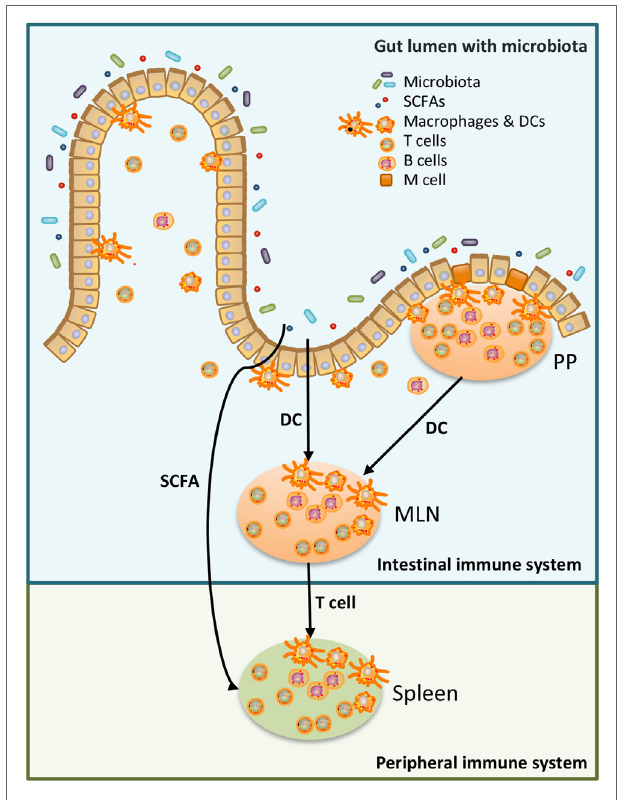
FigURe 1 | Schematic overview of the relation between microbiota, the intestinal immune system, and the peripheral immune system. Luminal microbiota and other products are continuously sampled and processed by the intestinal immune system. This could be done by specialized cells in the Peyer’s Patches (PP), microfold (M) cells, which transfer antigen to local dendritic cells (DCs). DC can present the antigen to T cells either in the PP or in the mesenteric lymph nodes (MLN). Alternatively, DC in the lamina propria sample antigen in the intestinal lumen and present antigen to T cells in the MLN (24, 25). T cells, which have recognized the antigen in the MLN, have access to the peripheral immune system and may affect the peripheral immune system (25). Moreover, metabolites produced by microbiota, such as short-chain fatty acid (SCFA), can also affect the peripheral immune system (26,